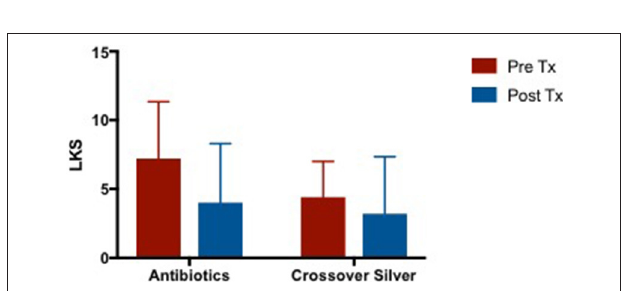
FIGURE 7 | Bar graph comparing LKS scores of patients following failed culture sensitive oral antibiotics and crossed-over to CS treatment. LKS, Lund Kennedy Scores; CS, Colloidal